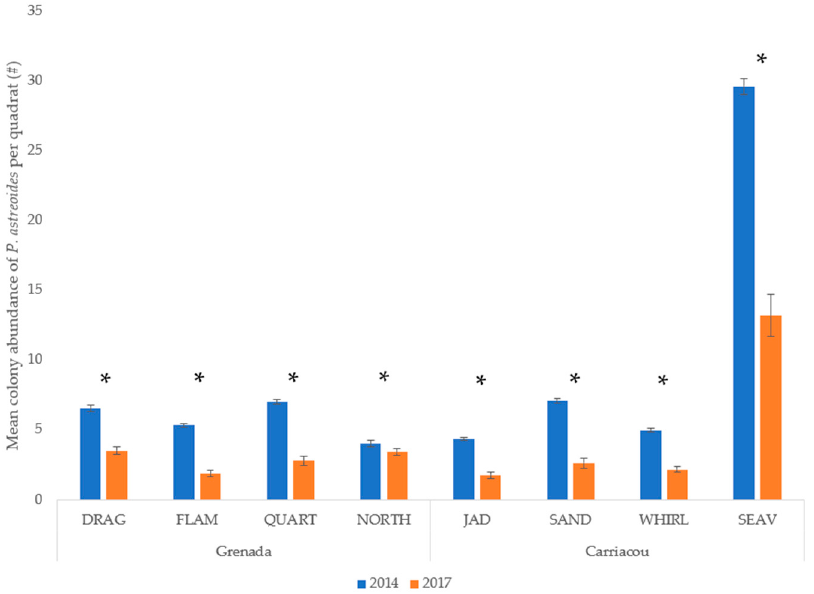
Figure 5. Mean colony abundance of P. astreoides per quadrat in 2014 and 2017 in Carriacou and Grenada. (*) denotes significance ( p < 0.05) between years.